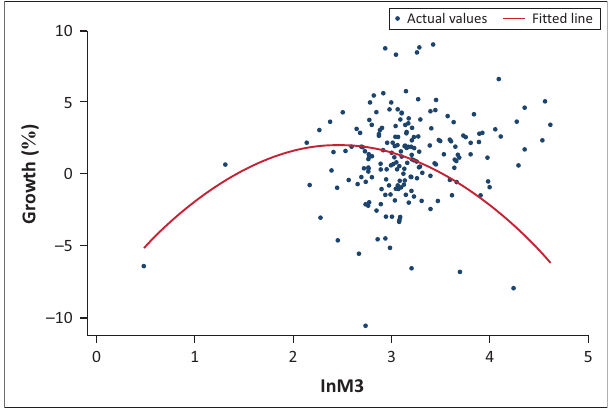
FIGURE 2: Liquid liabilities to gross domestic product ratio and